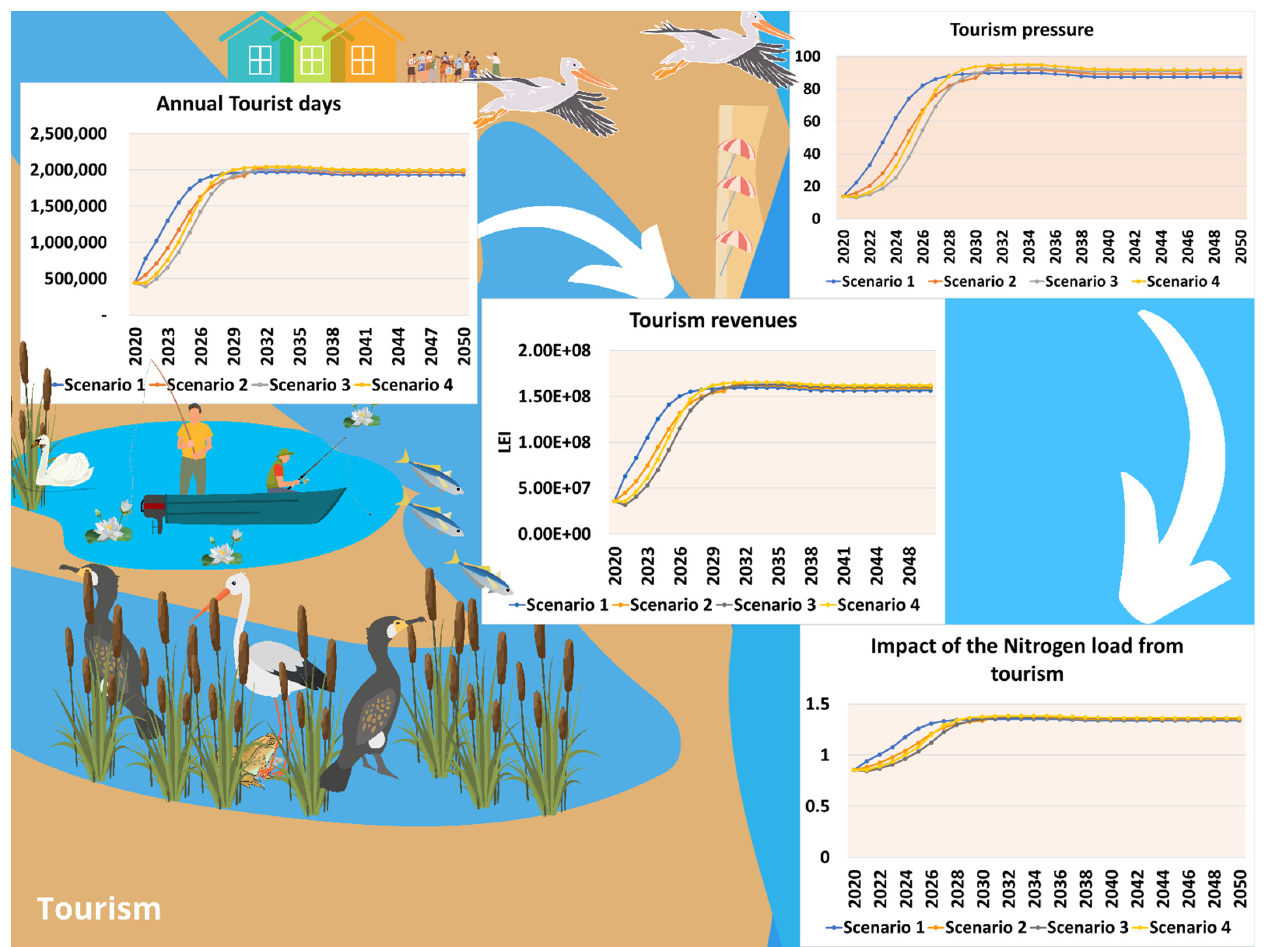
Figure 4. Tourism’s KPI change in different scenarios—Danube Delta. KPI 8: Impact of nitrogen from tourism on water